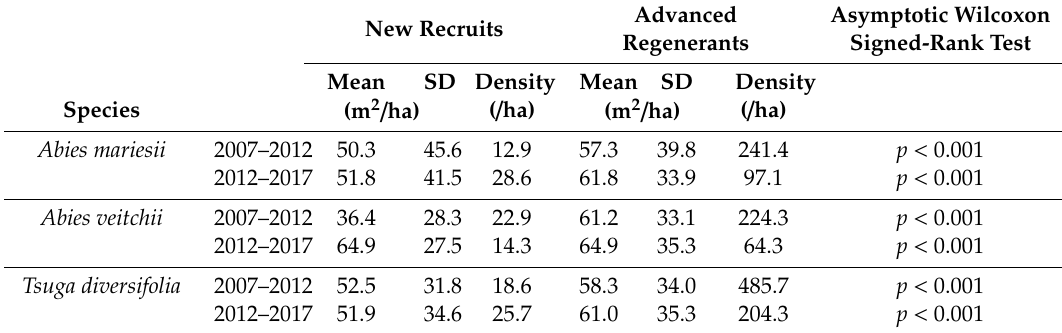
Table 2. Comparisons of cumulative basal area in each cell where saplings grew, as a competition index (CI).